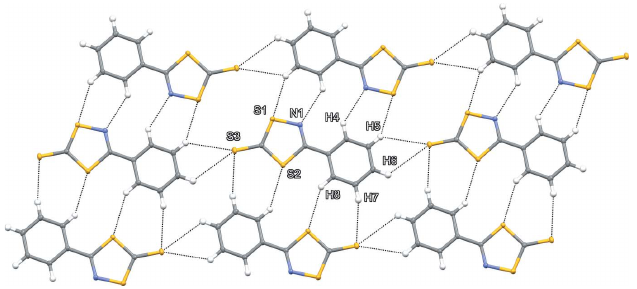
Figure 3 A packing diagram of the title compound showing hydrogen bonding in head-to-tail chains with flanking interactions where all possible hydrogen-bond donors and acceptors are participating in hydrogen